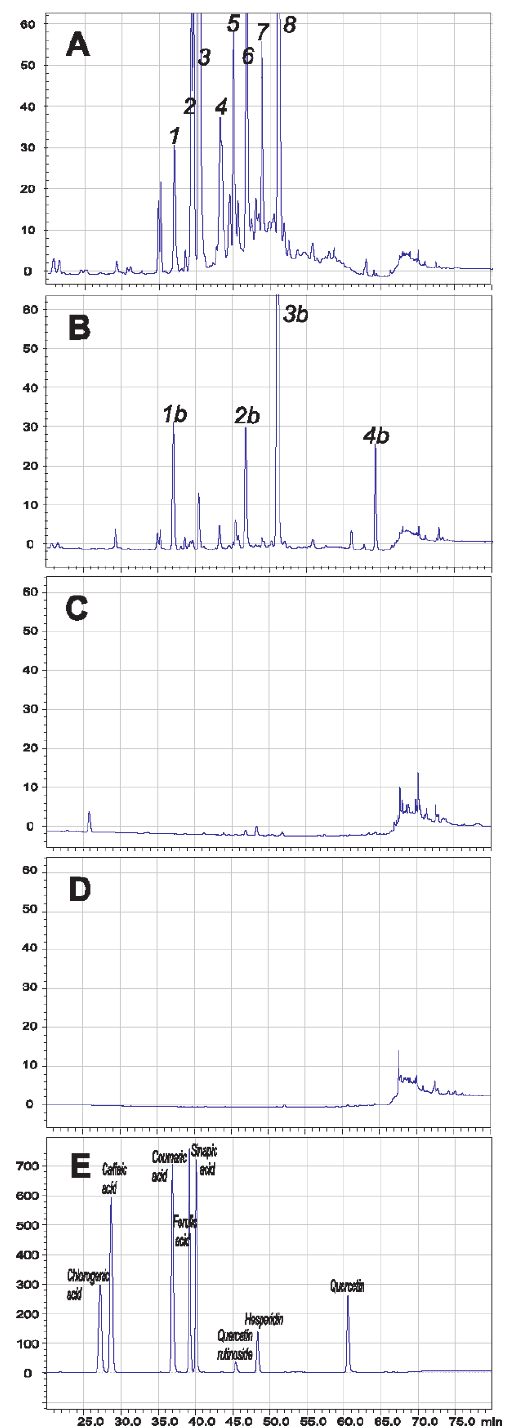
Figure 1. Comparison between elution HPLC curves of methanolic extracts of freeze-dried Callitriche shoots (a), shoots of Callitriche dried at 60ºC (b), Spirulina , (c), Chlorella (d) and mixture of standards (10 mg%) (e); y-axis absorbance [au] at 325 nm, x-axis retention time